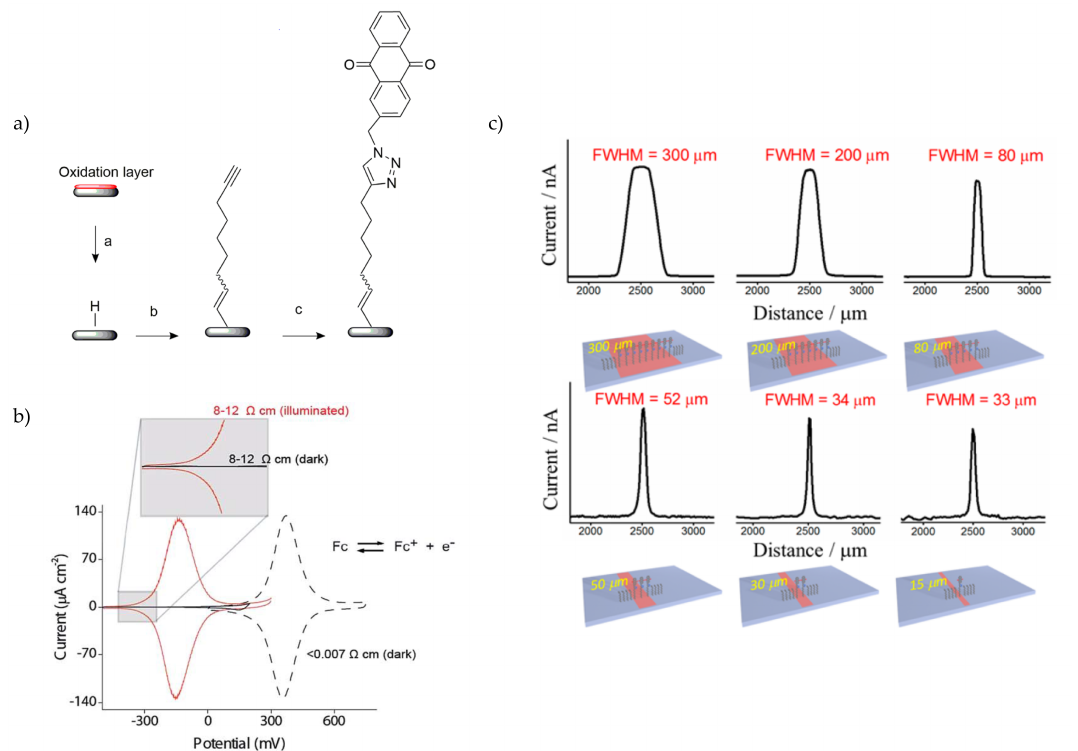
Figure 8. ( a ) Schematic of the process steps for addition of redox-active species (anthraquinone) on silicon. ( b ) Cycling voltammograms of highly doped p-type silicon(<0.007 Ω cm) without illumination compared to low-doped p-type silicon (1–10 Ω cm) without illumination (solid black line) and with rear-side illumination (solid red line). ( c ) Deposition of redox-active species with different widths (15–300 µ m) to perform top-side laser line scans to determine the minimum spatial resolution by comparison with the full width at half maximum (FWHM) of the photocurrent. Part (a) is reprinted (adapted) with permission from Yang et al. [95] Copyright (2020) American Chemical Society. Part (b) is adapted from Reference [92] under the CC BY licence. Part (c) is reprinted (adapted) with permission from Yang et al. [96] Copyright (2020) American Chemical